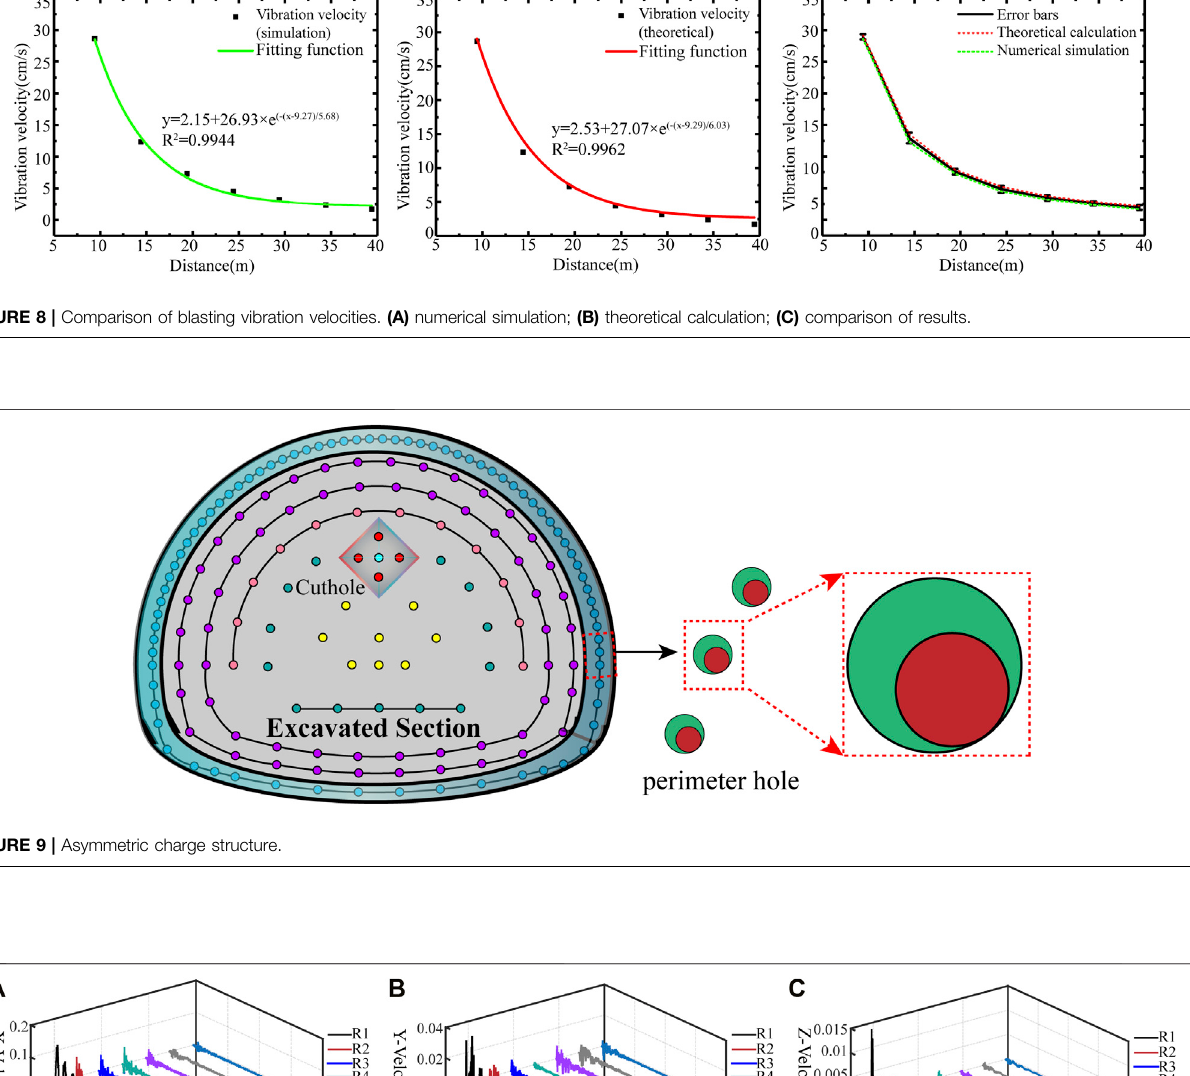
Figure 7 re fl ects the characteristics of the three-way vibration velocity distribution of the measurement points at different distances.